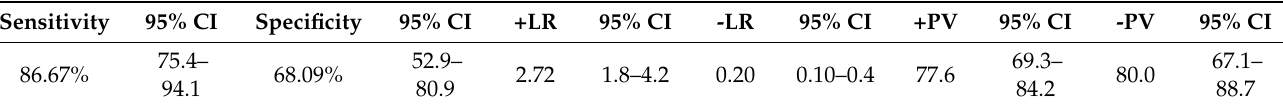
Table 4. Predictive values of the Helkimo Clinical Dysfunction Index (HCDI) total score by ROC curve analysis for the diagnosis of